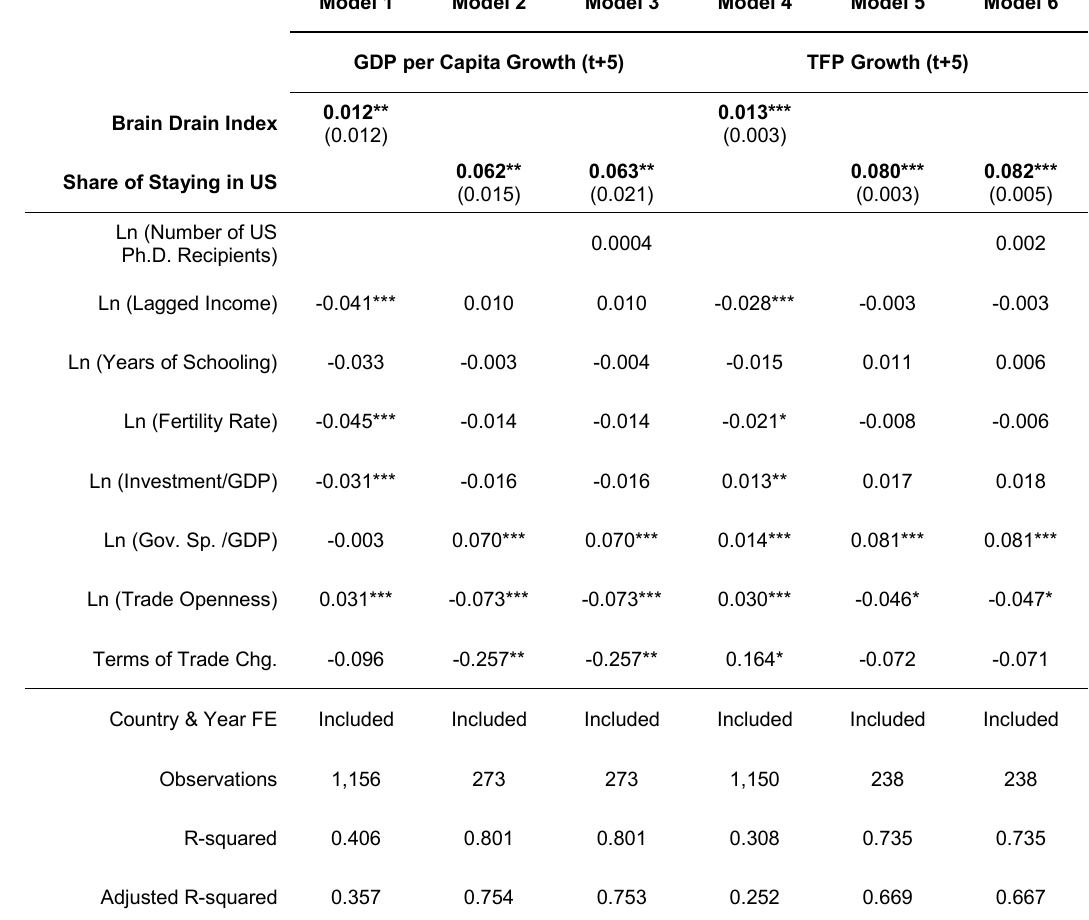
Table 7 . Results of linear regression of economic and total productivity